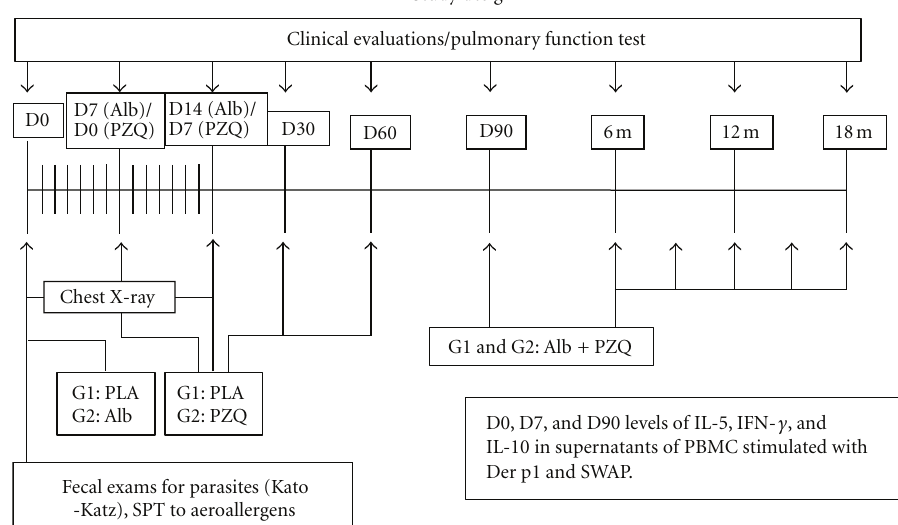
Figure 1: Flowchart of the study